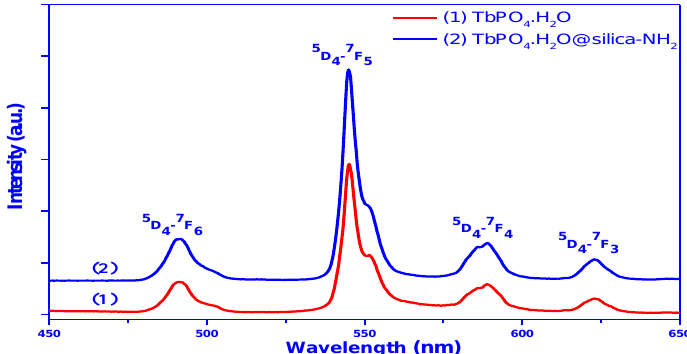
Figure 3. Fluorescence spectra of excitation at 355 nm of TbPO 4 · H 2 O incubated at 200 ◦ C for 24 h (1) and TbPO 4 · H 2 O@silica-NH 2 coated with a silica layer attached to NH 2 groups (2). The FTIR spectra of TbPO 4 ·H 2 O, TbPO 4 ·H 2 O@silica-NH 2 , TbPO 4 ·H 2 O@silica-NH 2 -mAb are